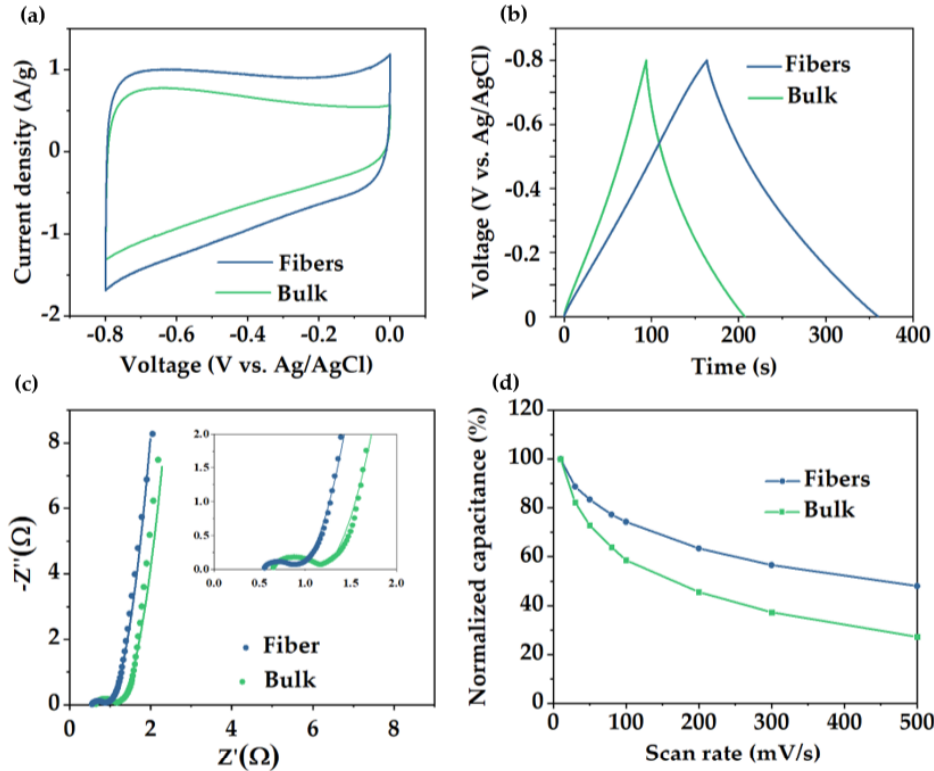
Figure 5. ( a ) CV curves at 5 mV/s scan rate, ( b ) GCD curves at 1 A/g current density, ( c ) EIS diagrams, and ( d ) capacitance retention of porous carbon fibers and carbon powders derived from PS − b − PAN. Table 1. Summary of specific surface area and specific capacitance values measured at different current densities ( A/g ) of various porous carbon fibers (PCFs) and porous carbon powder materials as electrodes for supercapacitors.